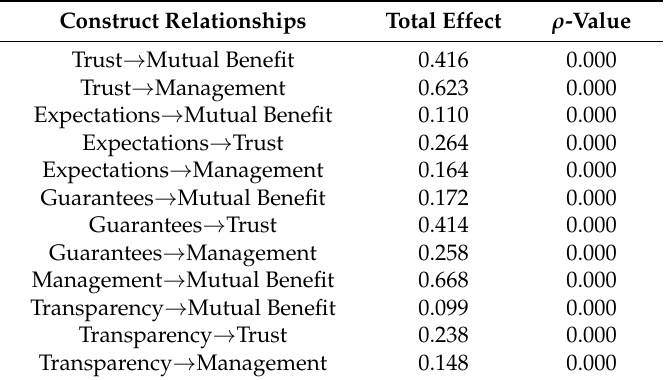
Table 6. Significance of the total effects of the variables.